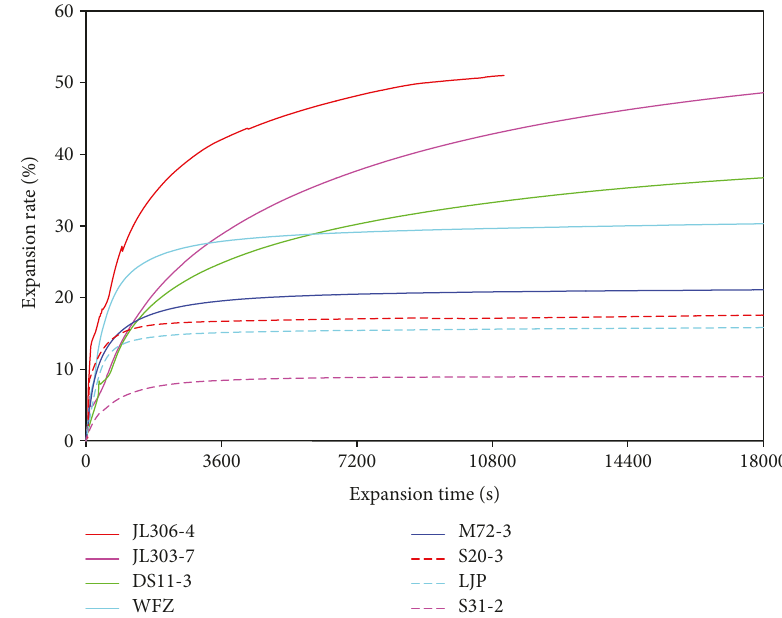
Figure 12: Sample expansion with time. JL306-4, JL303-7, and DS11-3 belong to volcanic gas sedimental rock; WFZ and LMX belong to shale gas rock.